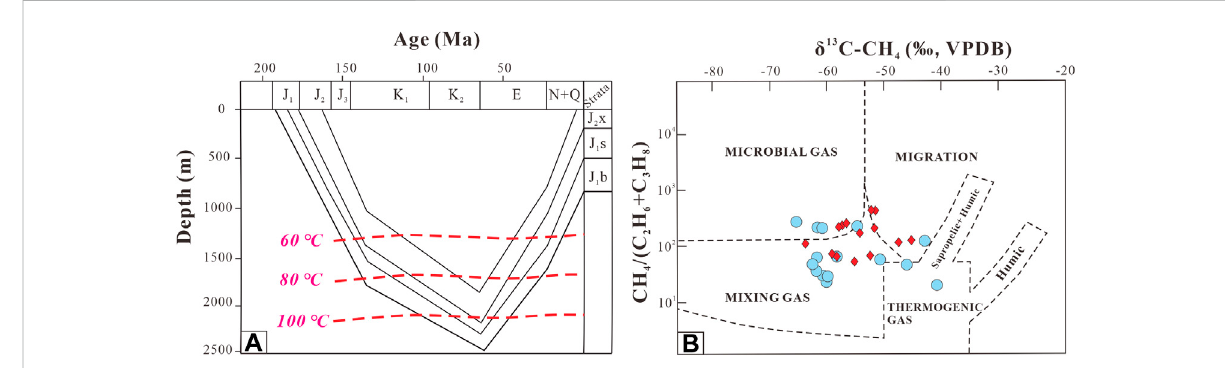
FIGURE 11 (A) Burial history of the southern Junggar Basin, showing basin wide subsidence during the Jurassic-Cretaceous, and Late Cretaceous- Quaternary uplift (modi fi ed after Wang et al., 2009). (B) Genetic characterization of coalbed methane from the southern Junggar Basin